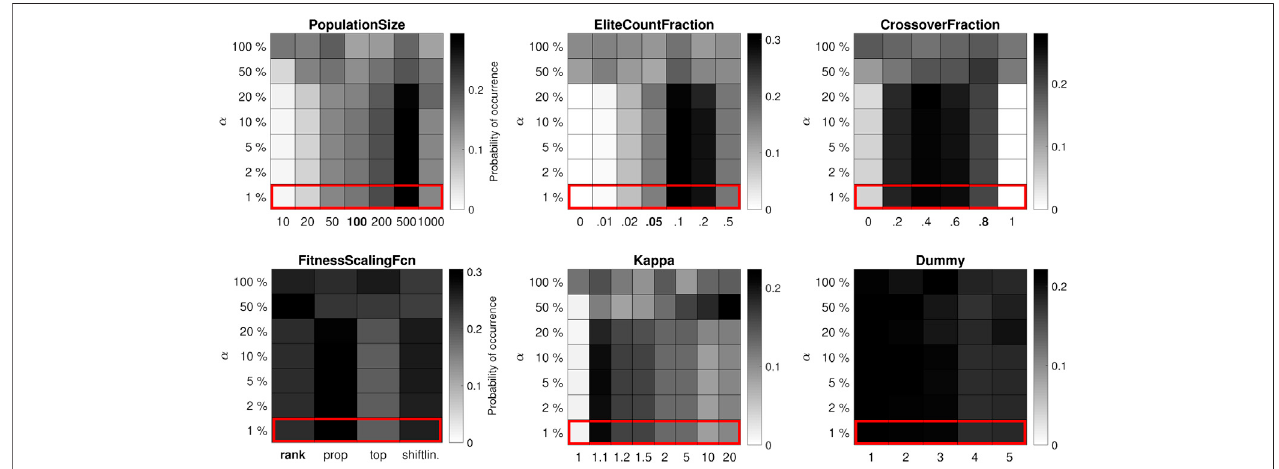
FIGURE 2 | Distribution of control parameter values for the 10-bar truss test problem, where each run of the algorithm has a medium budget of 10 5 function evaluations. The performance of the GA is less affected by the control parameter values.